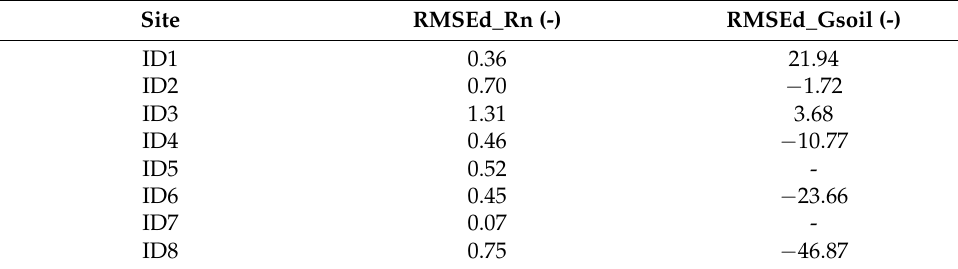
Table 6. The RMSEd for the modelled Rn and Gsoil variables.